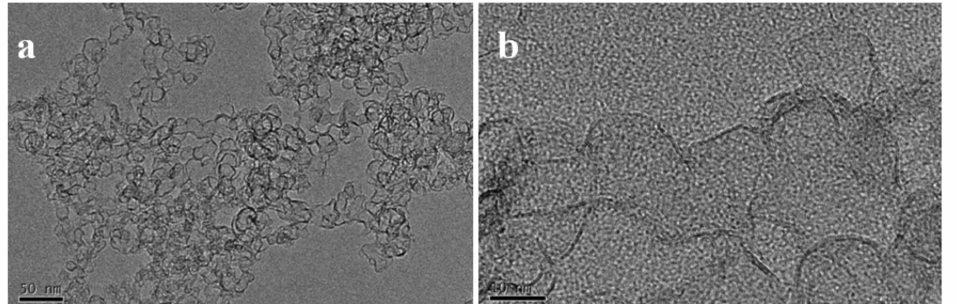
Figure 5. TEM images of the connective 3D graphene hollow cages obtained from the sample prepared at the FB − CVD temperature of 1300 ◦ C under pure Ar atmosphere (sample S4). ( a ) Low magnification, ( b ) High magnification.